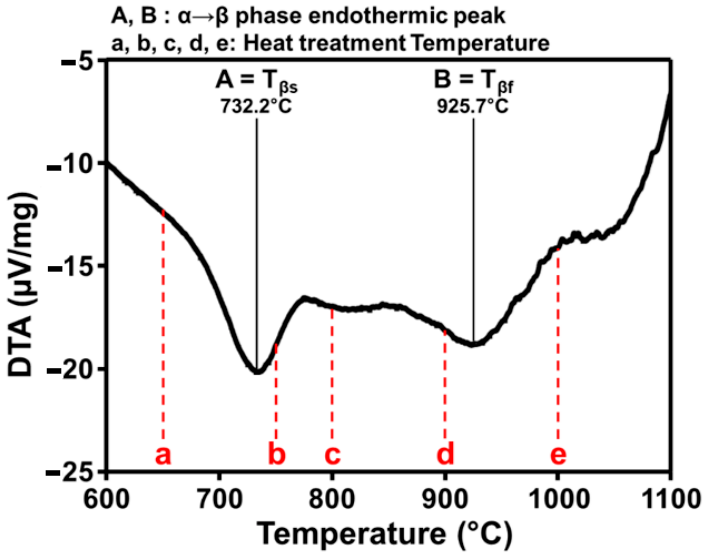
Figure 1. DTA thermogram of the SLM Ti-6Al-4V alloy. Points A and B indicate the endothermic peaks of the corresponding α and β phases.